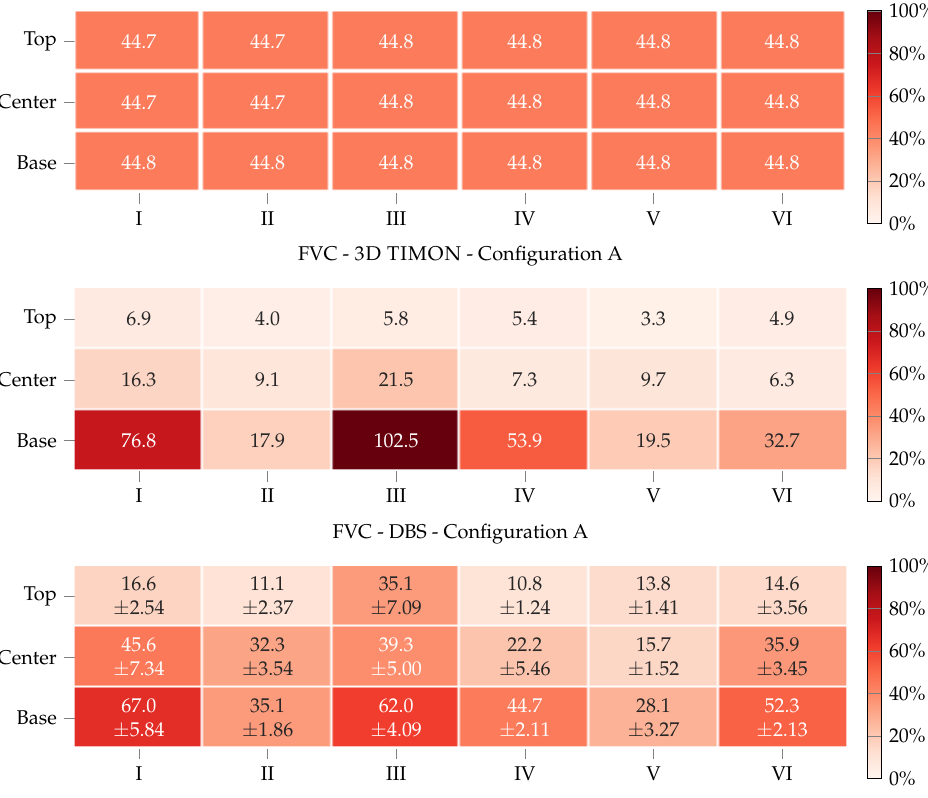
Figure 14. Fiber volume content of Configuration A according to M OLDEX 3D, the Direct Fiber Simulation and the Direct Bundle Simulation. The experimental results are shown in Figure